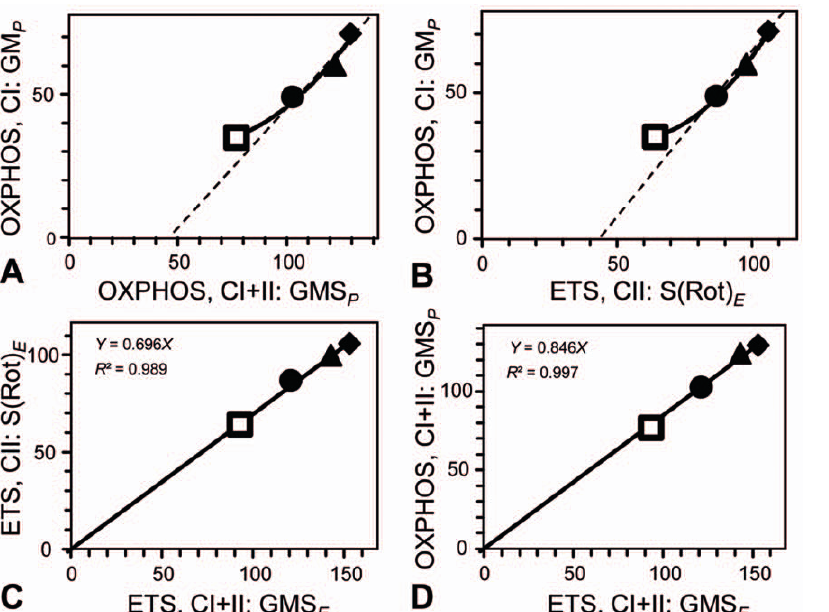
Figure 3. Substrate and coupling control of tissue mass-specific mitochondrial respiratory capacity (pmol ? s 2 1 ? mg 2 1 wet weight) in skeletal equine muscle at different levels of fitness. A : Substrate control of CI- versus CI + II-linked OXPHOS capacity; CI: glutamate + malate (GM); CI + II: glutamate + malate + succinate (GMS). B : Substrate control of CI- versus CII-linked respiratory capacity; CII: succinate + rotenone, S(Rot). Dashed lines: linear trend for normal BCS horses, extrapolated to zero; CI-linked capacity increases overproportionally with fitness level. C : Substrate control of CII- versus CI + II-linked ETS capacity (GMS) increasing in constant proportion with fitness level. D : Coupling control of OXPHOS versus ETS capacity with CI + II-linked electron input (GMS). The slopes (full lines, forced through zero) provide an estimate of the CII/CI + II substrate control ratio ( C ) and P/E coupling control ratio ( D ). All axes are scaled at 110% of the maximum value (average of competitive horses). Open squares: overweight- untrained; closed circles, triangles and diamonds: normal BCS – untrained, trained and competitive, respectively.